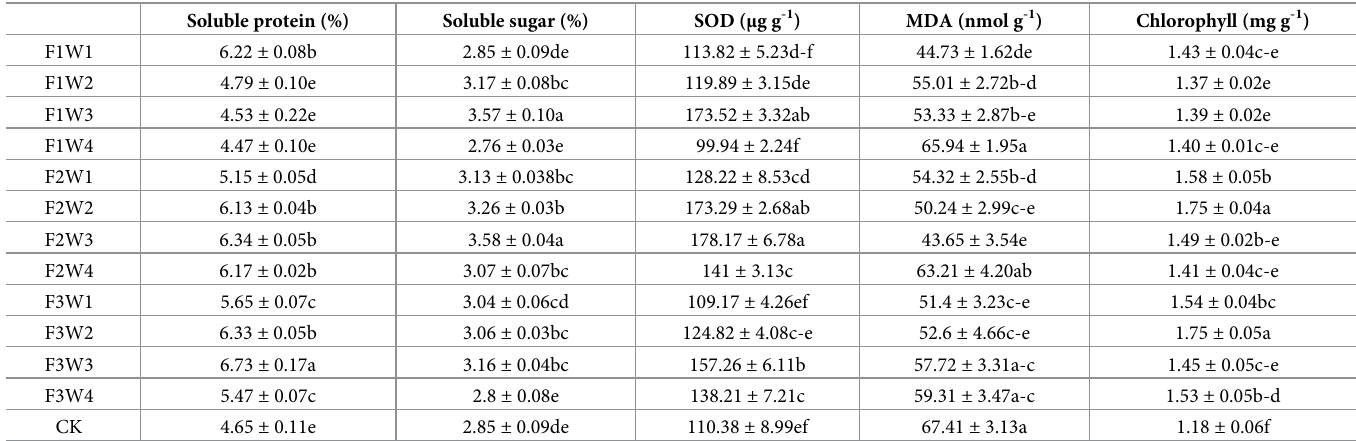
F1 = Low fertilizer [29 + 5 +10 g plant -1 (NH 4 ) 2 SO 4 + Ca(H 2 PO 4 ) 2 + K 2 SO 4 , respectively]; F2 = Medium fertilizer [59 + 10 +20 g plant -1 (NH 4 ) 2 SO 4 + Ca(H 2 PO 4 ) 2 + K 2 SO 4 , respectively]; F3 = High fertilizer [118 + 20 +40 g plant -1 (NH 4 ) 2 SO 4 + Ca(H 2 PO 4 ) 2 + K 2 SO 4 , respectively]; W1 = Low water (1.25 L plant -1 ); W2 =